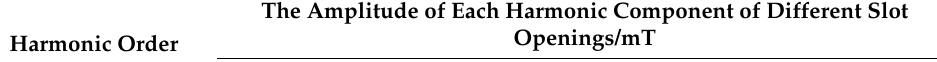
Table 3. FFT on air gap flux density.